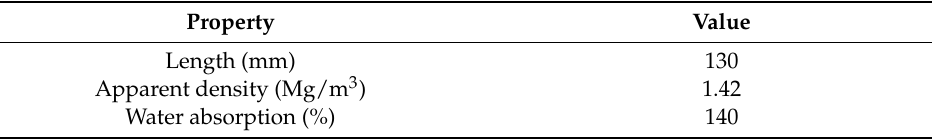
Figure 1. Sample of coconut fiber. Table 4. Properties of the CF.